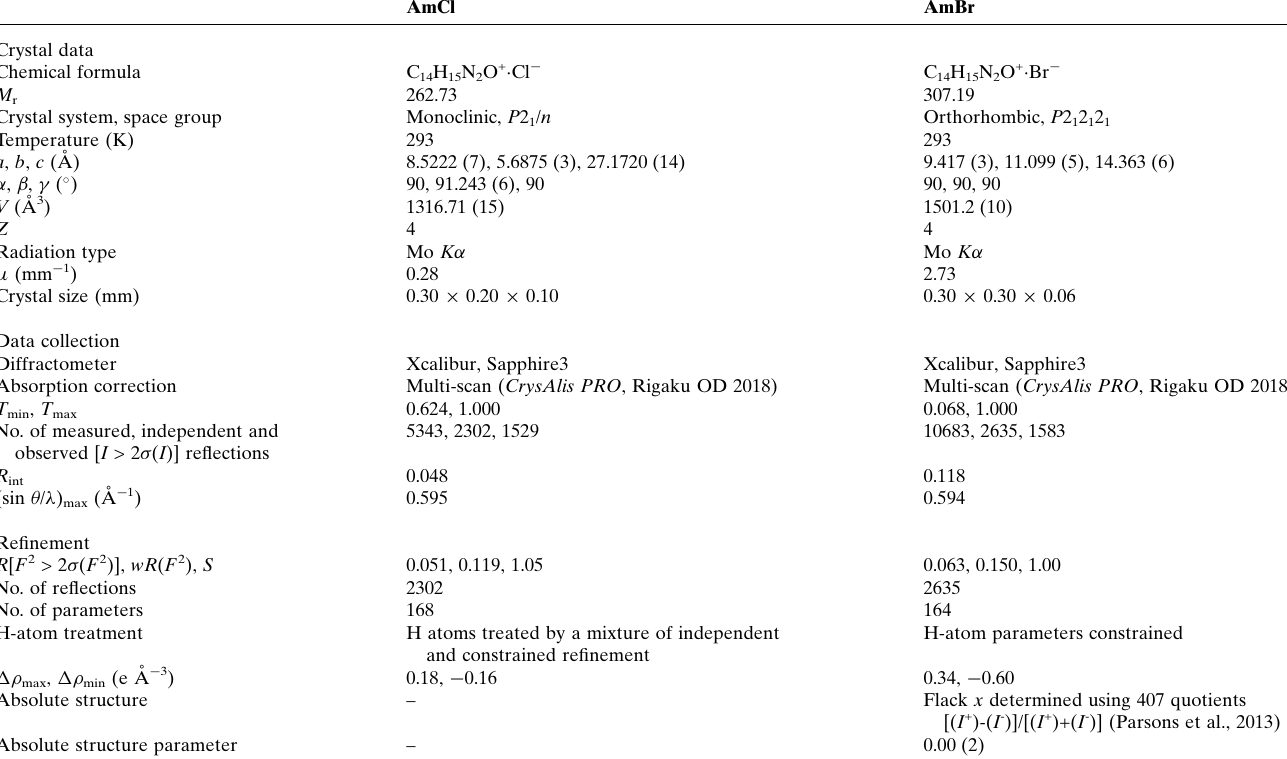
Table 4 Experimental details.